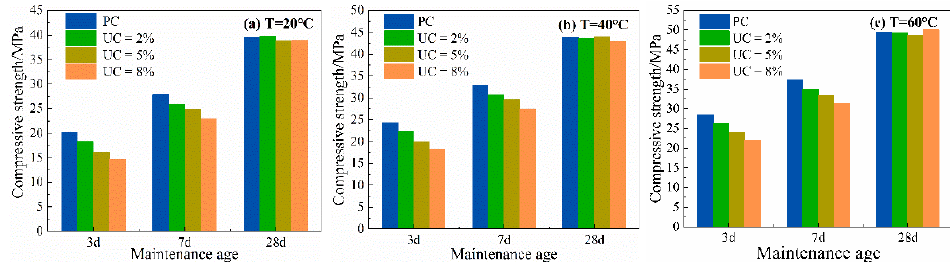
Figure 4. Compressive strength of cement mortar at different temperatures.